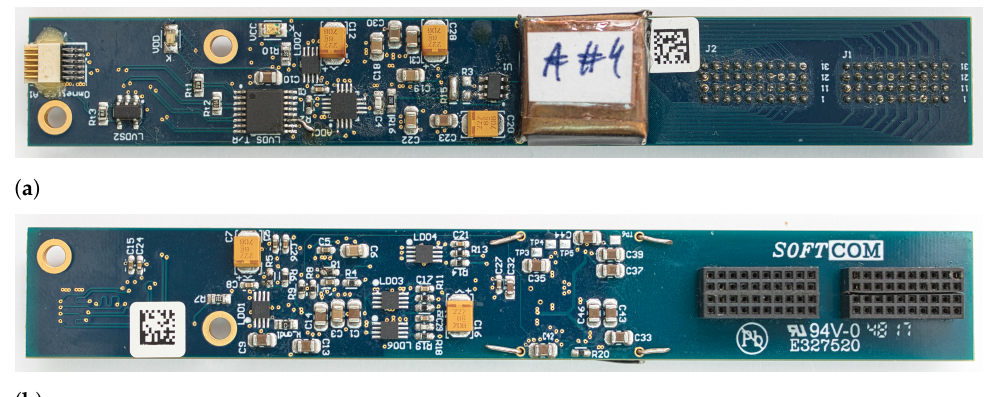
Figure 3. One of the possible configurations of AB with MEA connector ( a ) top view ( b ) bottom view. Neurostim-3 ASIC is not visible directly since it is enclosed inside the copper shielding (with the label A#4 indicating the particular copy of the